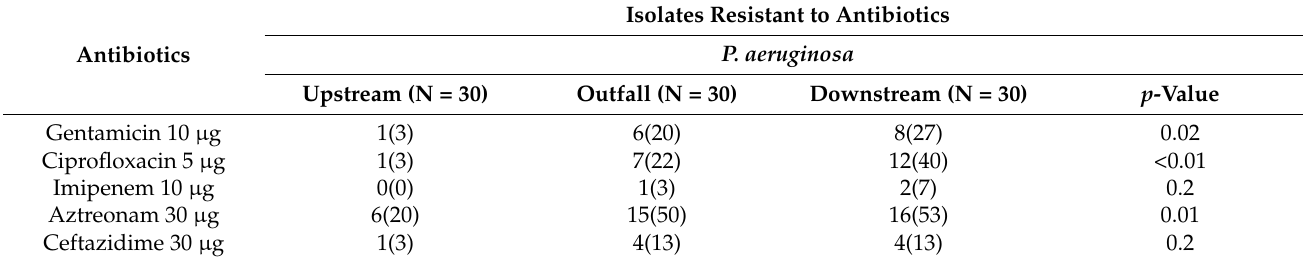
Ceftazidime 30 µ